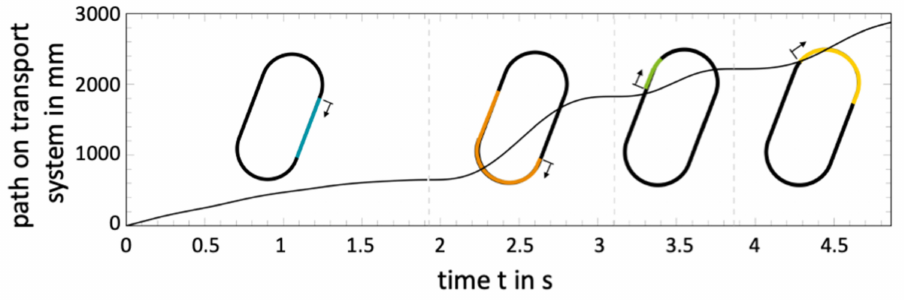
Figure 14. Curve of distance traveled by the gripper on the transport system using the example of the reference format with 304 × 129 mm; one-sided representation of the z-folding unit